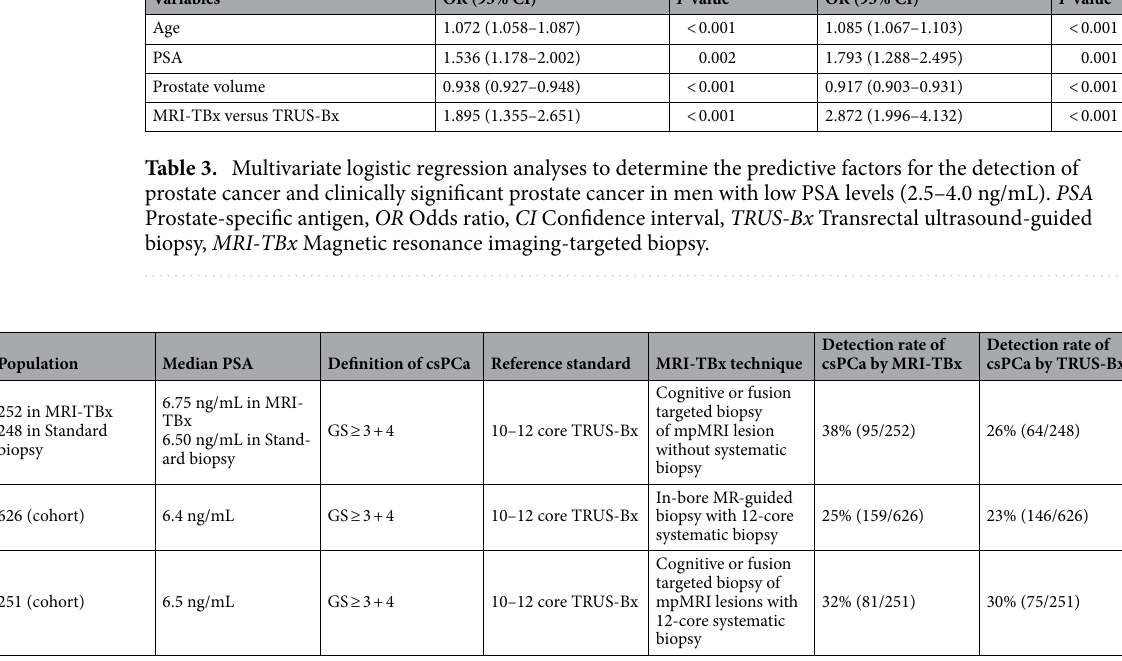
Table 4. Data from three major manuscripts of MRI-TBx. csPCa Clinically significant prostate cancer, PSA Prostate-specific antigen, TRUS-Bx Transrectal ultrasound-guided biopsy, MRI-TBx Magnetic resonance imaging-targeted